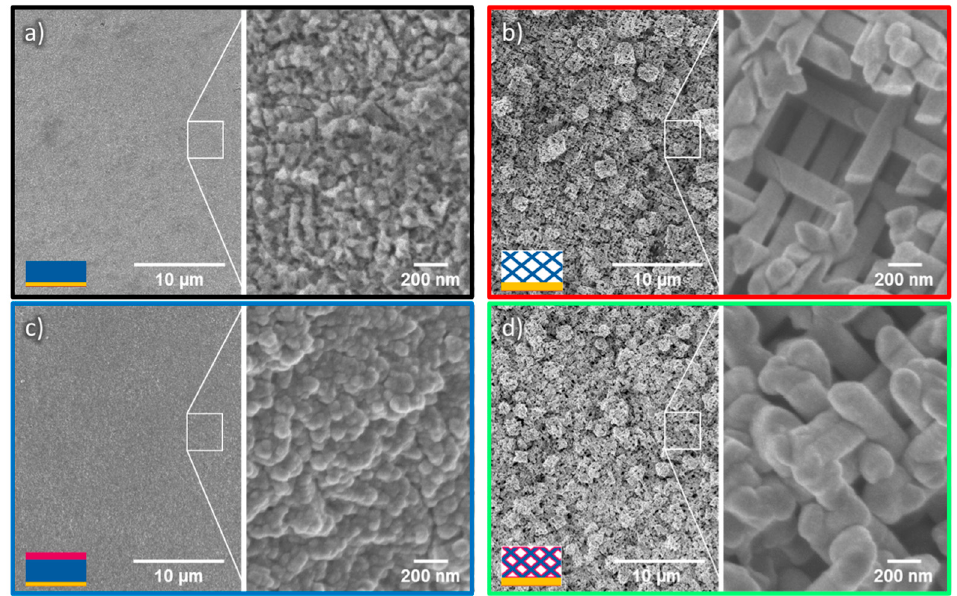
Figure 6. Low (left) and high (right) magnification SEM images, displaying ( a ) a ZnO film exhibiting a rough surface and spike-like features; ( b ) a ZnO nanowire network; ( c ), a ZnO film coated with 20 nm TiO 2 and ( d ) a ZnO/TiO 2 core-shell nanowire network. In the insets’ schemes, the colors present the different materials: gold (yellow), ZnO (blue), and TiO 2 (pink). After their morphological characterization, the samples were mounted into the photoelectrochemical cell and LSVs were recorded for each of the four samples under chopped light conditions (Figure 7).